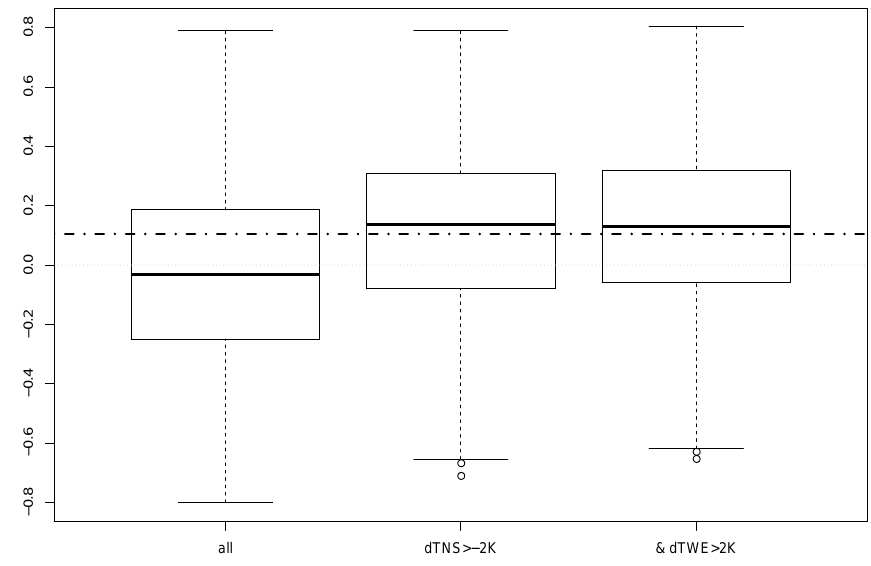
Fig. 5. Box-and-whisker plots of spatial correlations between the composite pattern of sea level pressure (from NCEP reanalysis) obtained for days of high North-South temperature difference between April and August: all days (“All”), days with N-S temperature differences larger than − 2K (“dTNS > − 1.5K”), days with N-S temperature differences larger than − 2K and W-E temperature differences larger